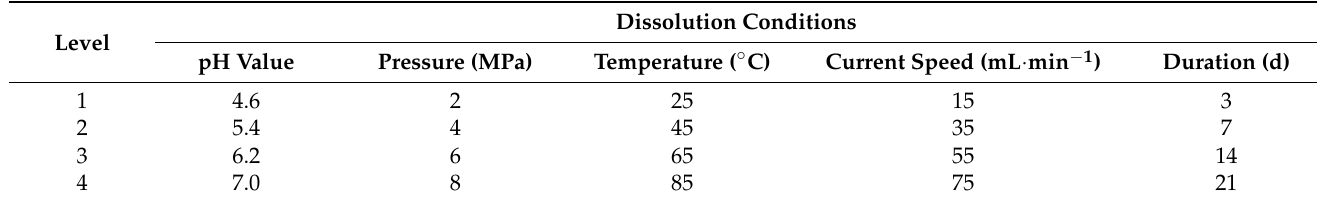
Table 3. Research level of orthogonal numerical simulation experimental